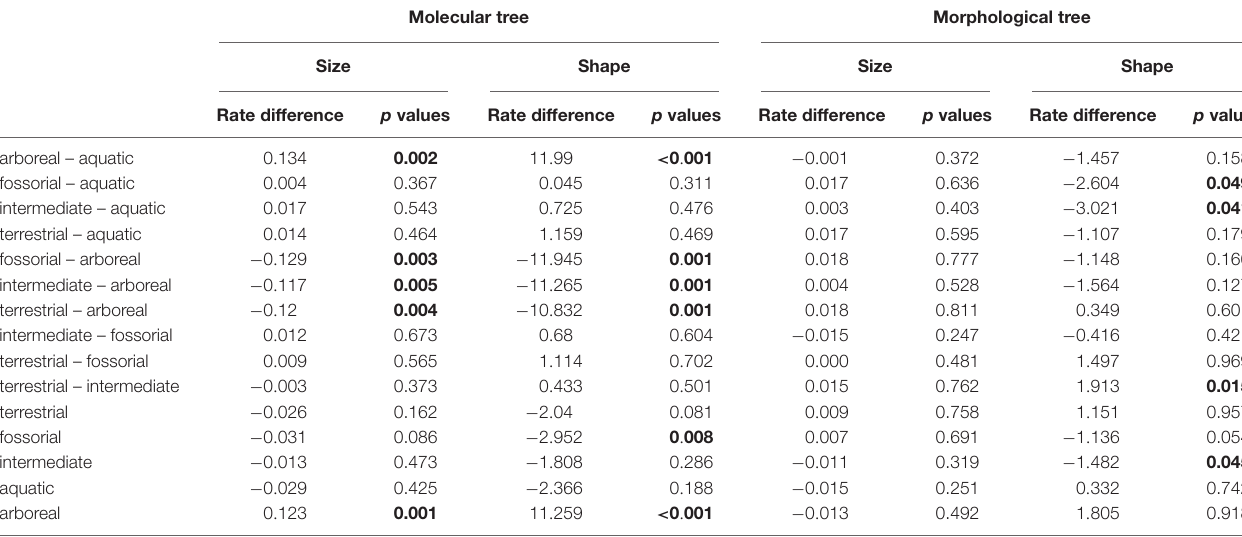
TABLE 4 | search.shift results for size showing shift in evolutionary rate. Molecular tree Morphological